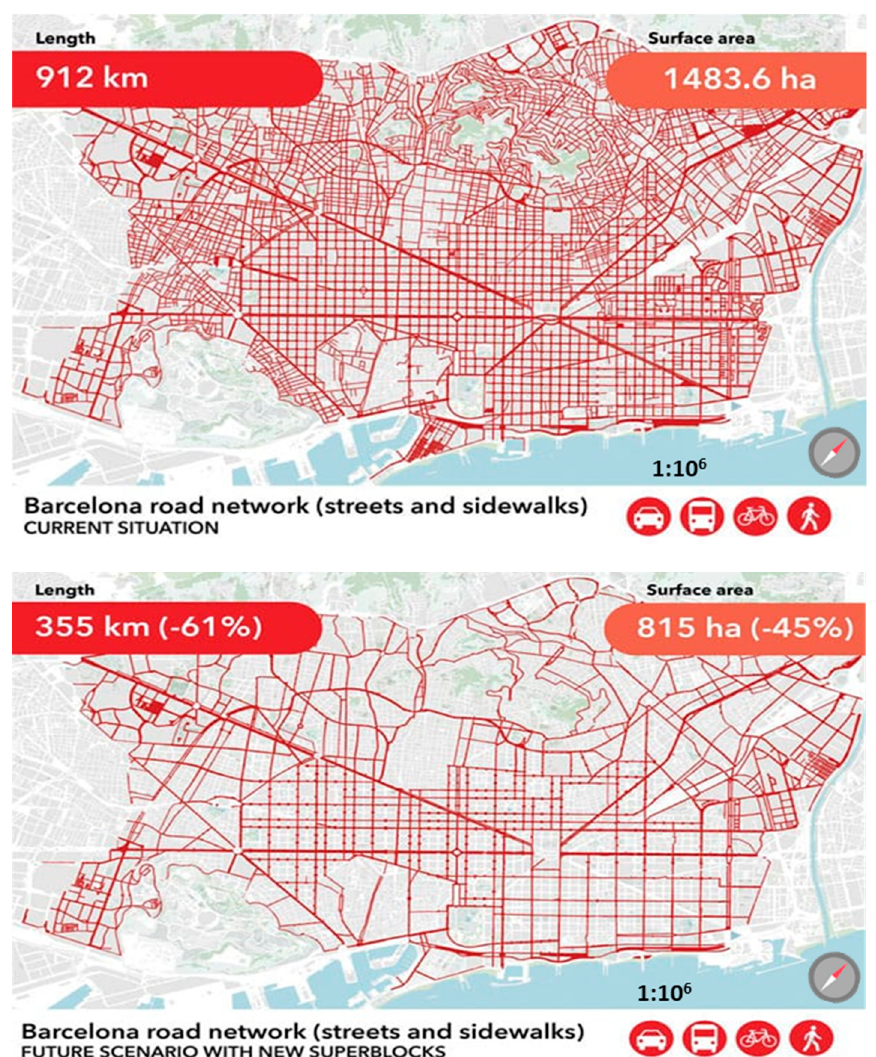
Figure 6. Barcelona road network, current situation and future scenario with new Superblocks. Source: Reproduced from [15].